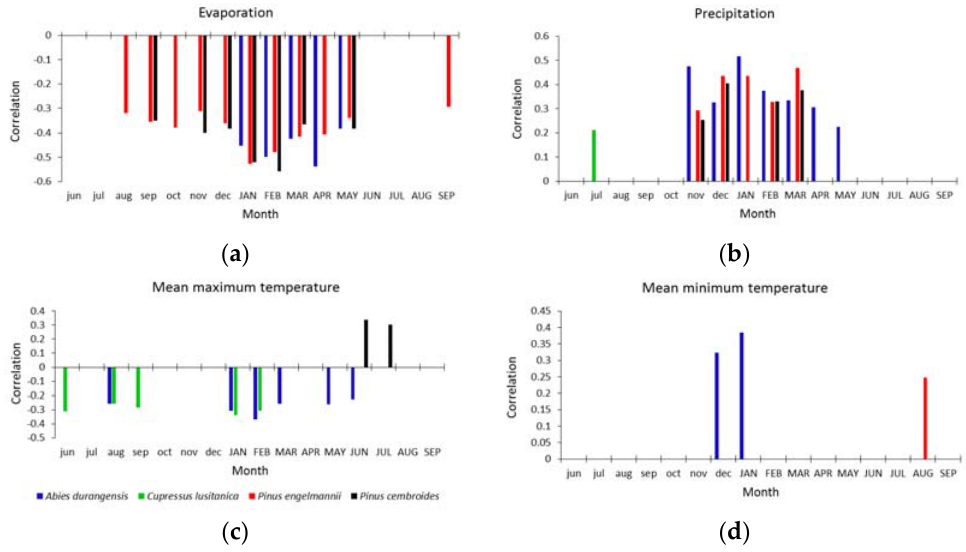
Figure 3. Climate–growth associations (Pearson correlations) for the four species studied with regard to the following climatic variables: ( a ) evaporation; ( b ) precipitation; ( c ) maximum temperature; and ( d ) minimum temperature. Only the significant correlations ( p < 0.05) are shown. The previous ‐ and current ‐ year months are symbolized by lowercase and uppercase letters, respectively.